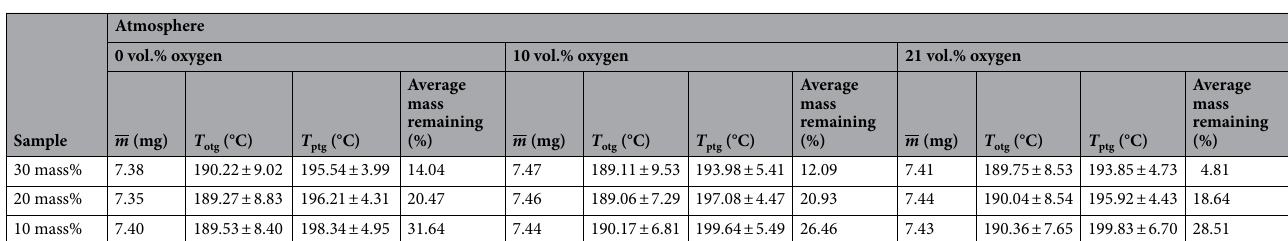
Table 2. Thermodynamic parameters of NC-S measured by TG experiment in different atmosphere conditions.